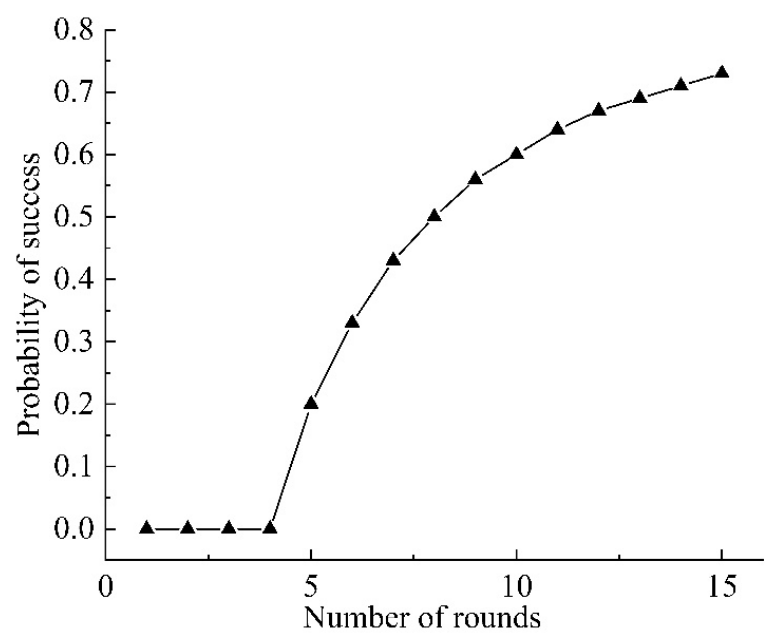
Figure 12. The agent trains to score points per turn.